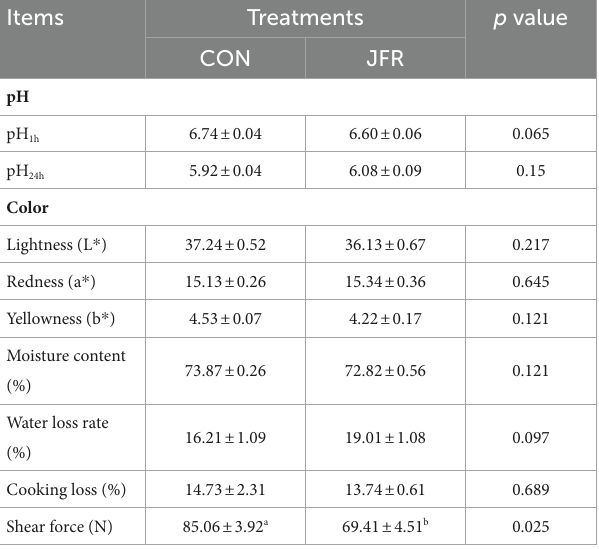
TABLE 2 Effect of dietary jasmine flower residue supplementation on meat quality.